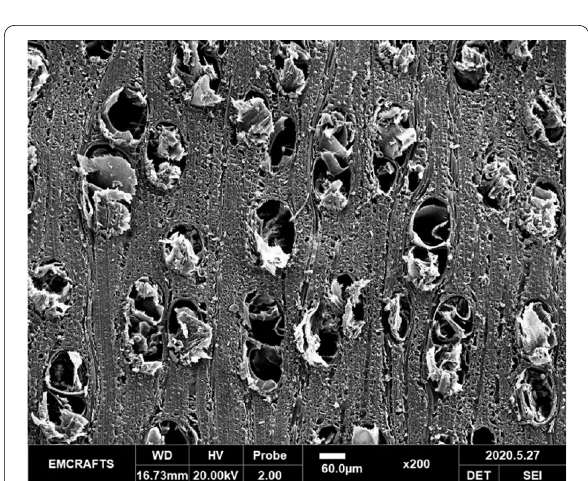
Fig. 4 SEM image of the cross‑sectional surface of untreated Malas